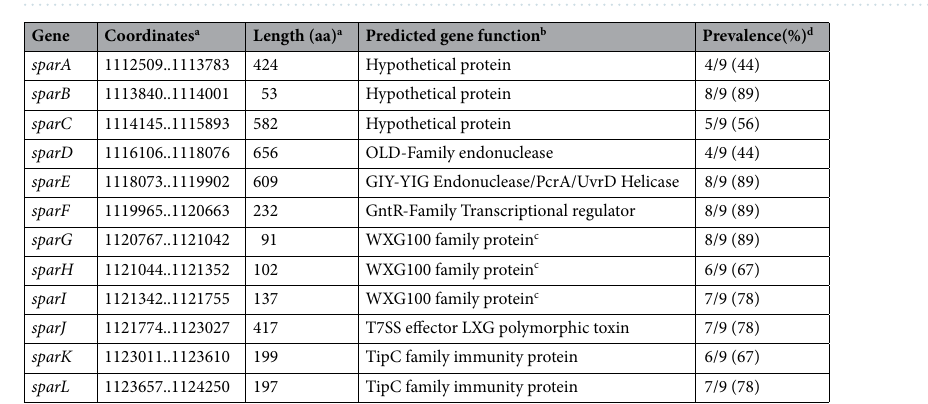
Table 1. Proteins encoded by the SPAR genes. a Based on the annotated genome of TX20005 (NZ_ CP077423.1). b The amino acid sequence of each protein was used to search the Non-redundant protein sequences database (updated on 04/05/2022) at NCBI using Protein BLAST. c Based on characteristic sequence motifs and structural fold predictions displaying features of WXG100 proteins. d The amino acid sequence of each protein was used to search the nine complete Sgg genomes at NCBI using BLAST Genomes, optimized for highly similar sequences (megablast). The number of genomes containing highly similar sequences vs. the total number of genomes searched are shown. The numbers in the parenthesis indicate the percentage of positive genomes.